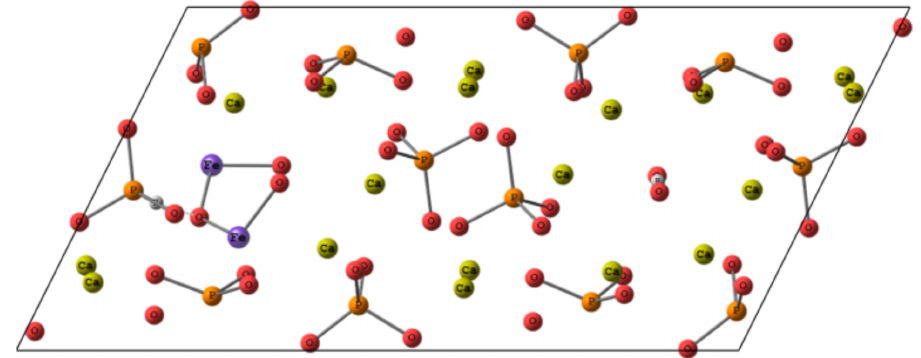
Figure 11. The scheme of putative Fe 2 O 3 location in HA